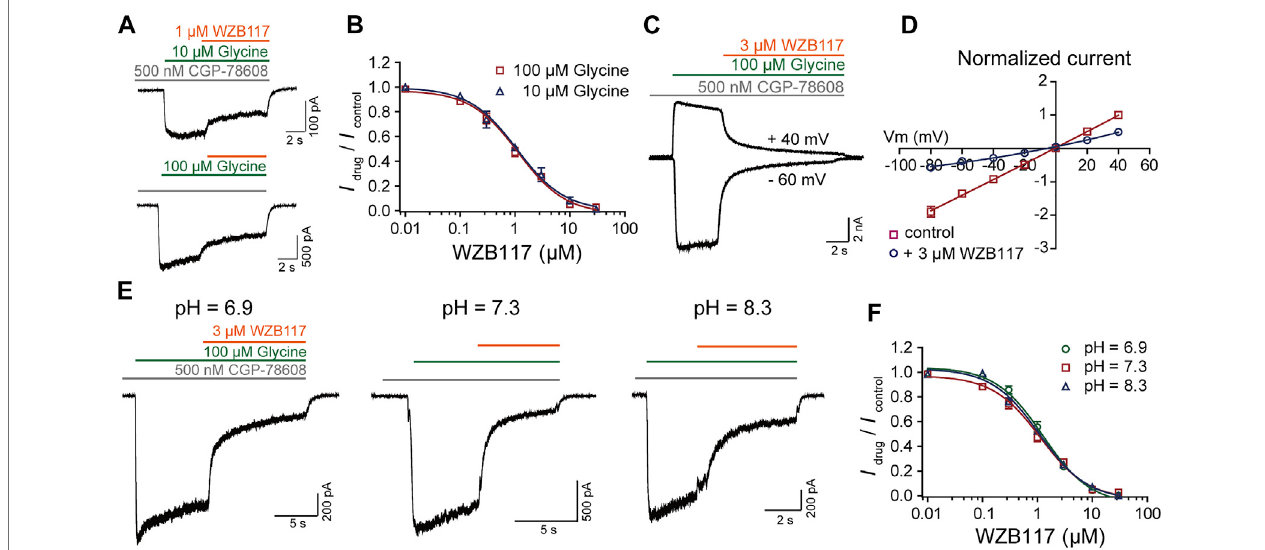
FIGURE5| Inhibition mechanismofWZB117 on GluN1/GluN3A receptors. (A) Representative traces ofGluN1/GluN3A receptors inthe presence ofglycineat the indicated concentrations. (B) Dose-response curves of WZB117 under agonistic conditions of 10 μ M (blue) and 100 μ M (red) glycine. (C) Representative traces of GluN1/GluN3A receptors in the presence of 3 μ M WZB117 at membrane potentials of − 60 mV and +40 mV. (D) Effect of 3 μ M WZB117 on the current-voltage relationship ofGluN1/GluN3A receptors.The I - V curveswererecordedat membranepotentialsranging from − 80 mV to+40 mV, and thecurrentamplitudes were normalized to the response of control at +40 mV. (E) Representative traces following 3 μ M WZB117 inhibition of GluN1/GluN3A receptors at pH values of 6.9, 7.3, and 8.3. (F) Dose-response curves of WZB117 on GluN1/GluN3A receptors at pH of 6.9 (green), 7.3 (red) and 8.3 (blue). All data were recorded from GluN1/GluN3A Flp-in T-REx 293 stable cell